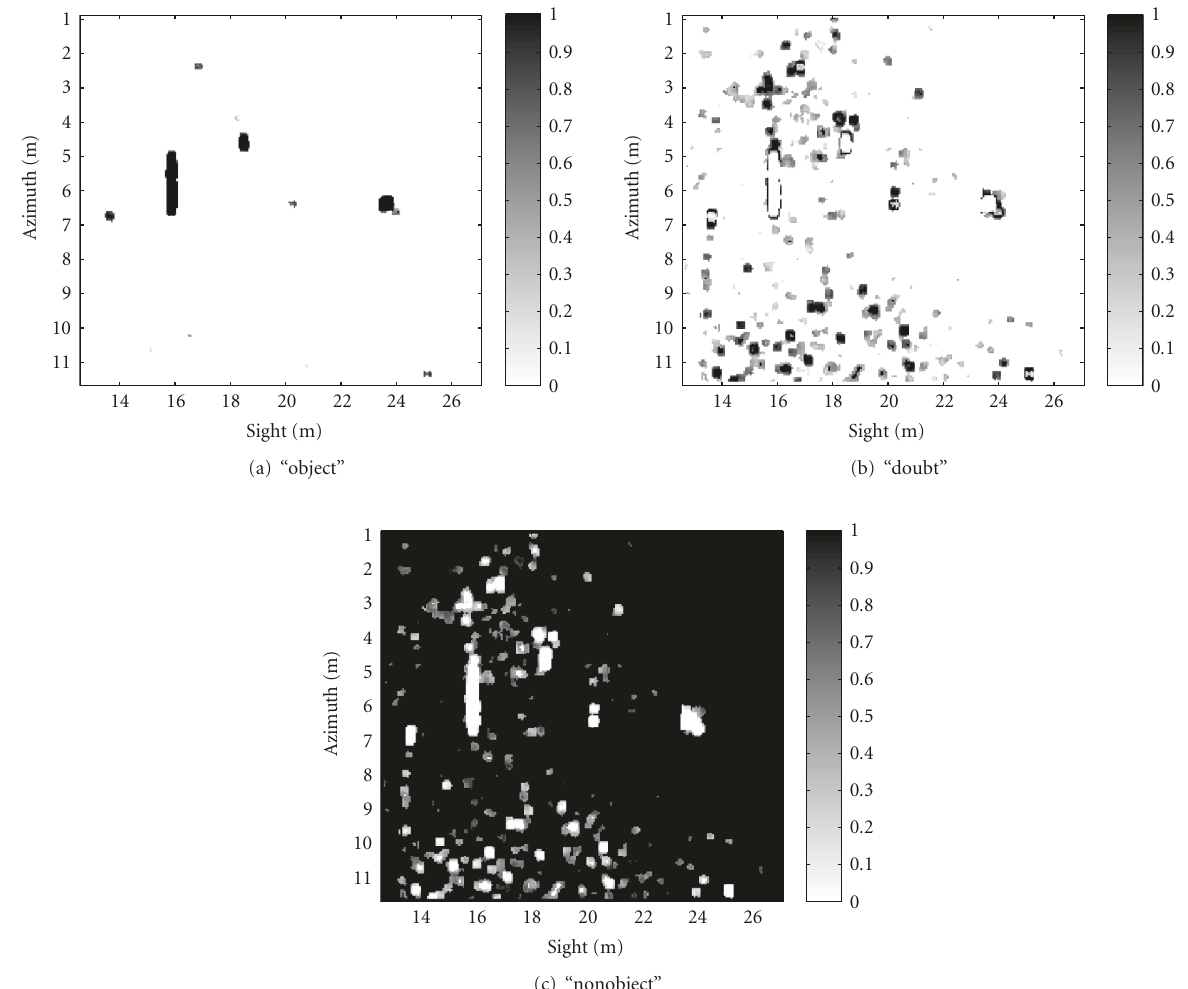
Figure 13: Mass images obtained for each proposition after the fusion of the mean standard deviation parameter (segmentation) in image 1.